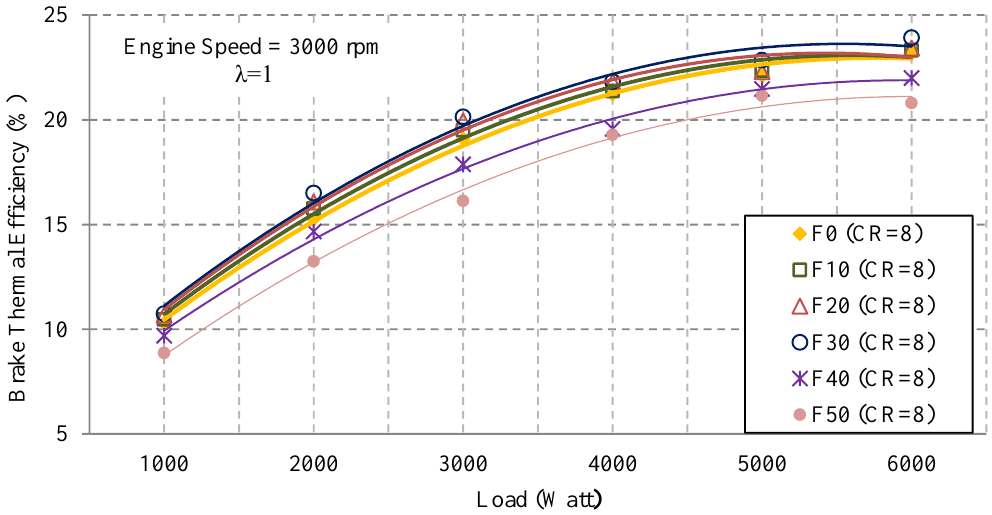
Figure 5. Overall e ffi ciency graph based on an engine load at a cylinder head (CR) of Figure 5. Overall efficiency graph based on an engine load at a cylinder head (CR) of 8:1.